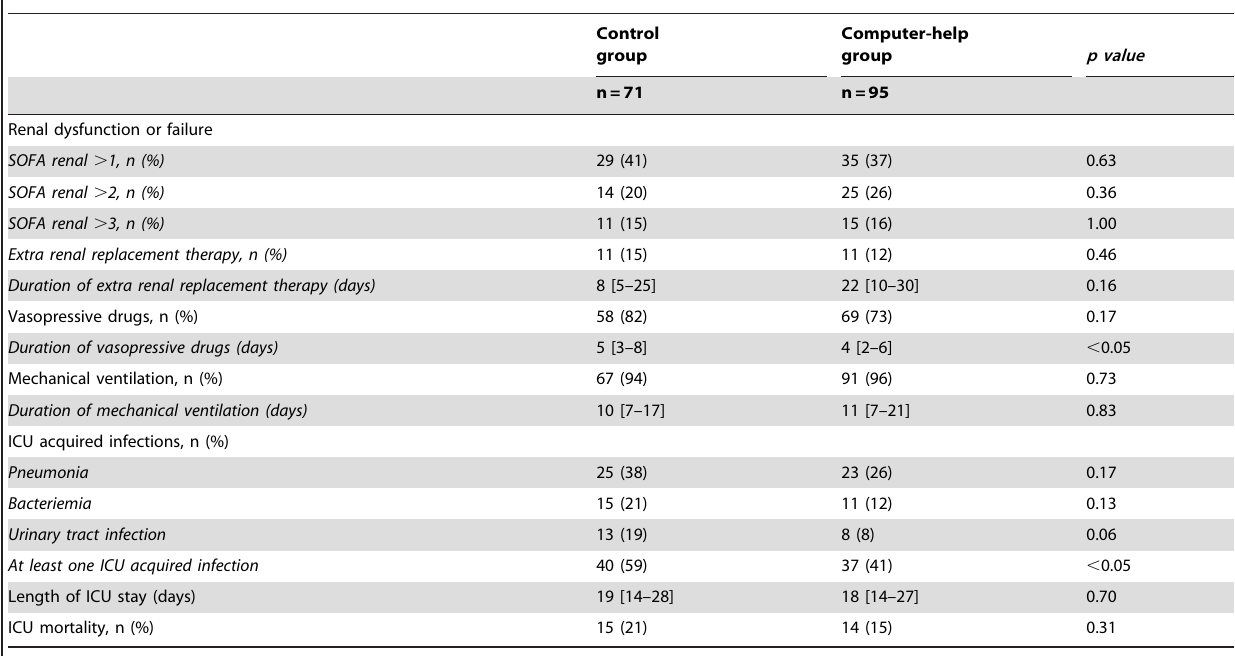
Table 3. Clinical outcome at ICU